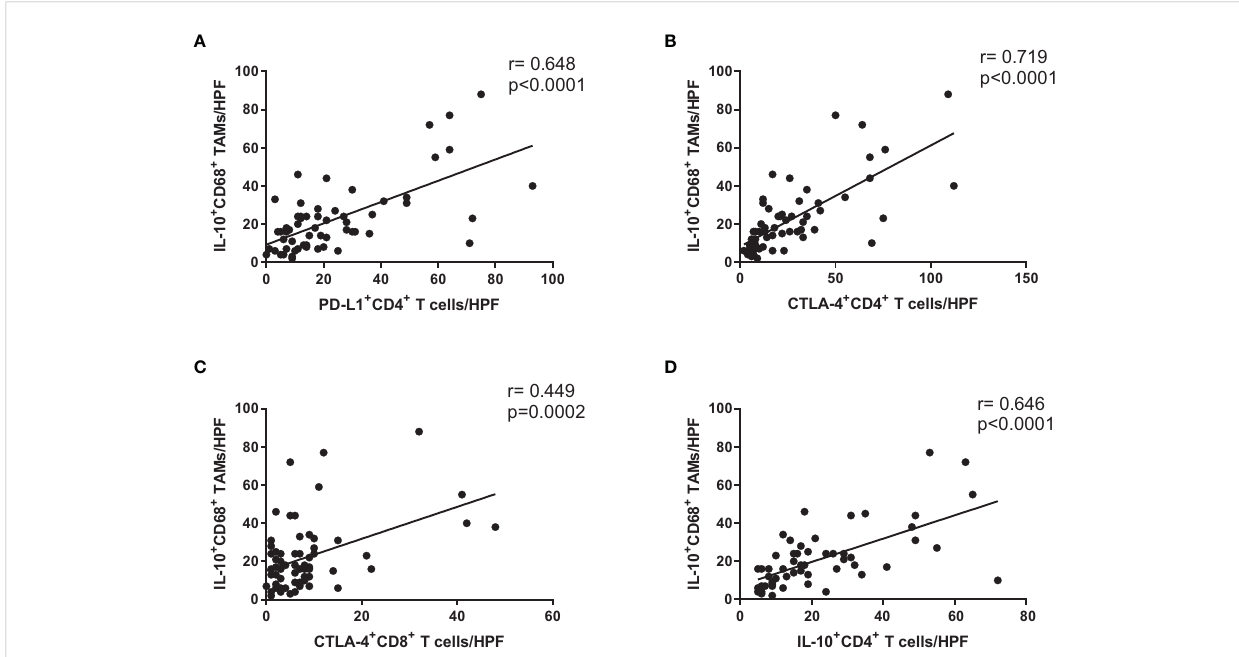
FIGURE 4 Expression levels of immunosuppressive markers on CD4 + and CD8 + T cells were correlated with number of IL-10-producing CD68 + macrophages in cancer tissue from GC patients. Correlation analysis of (A) PD-L1 + CD4 + T cells, (B) CTLA-4 + CD4 + T cells, (C) CTLA-4 + CD8 + T cells, and (D) IL- 10 + CD4 + T cells with number of IL-10 + CD68 + TAMs in cancer tissue from stage III GC